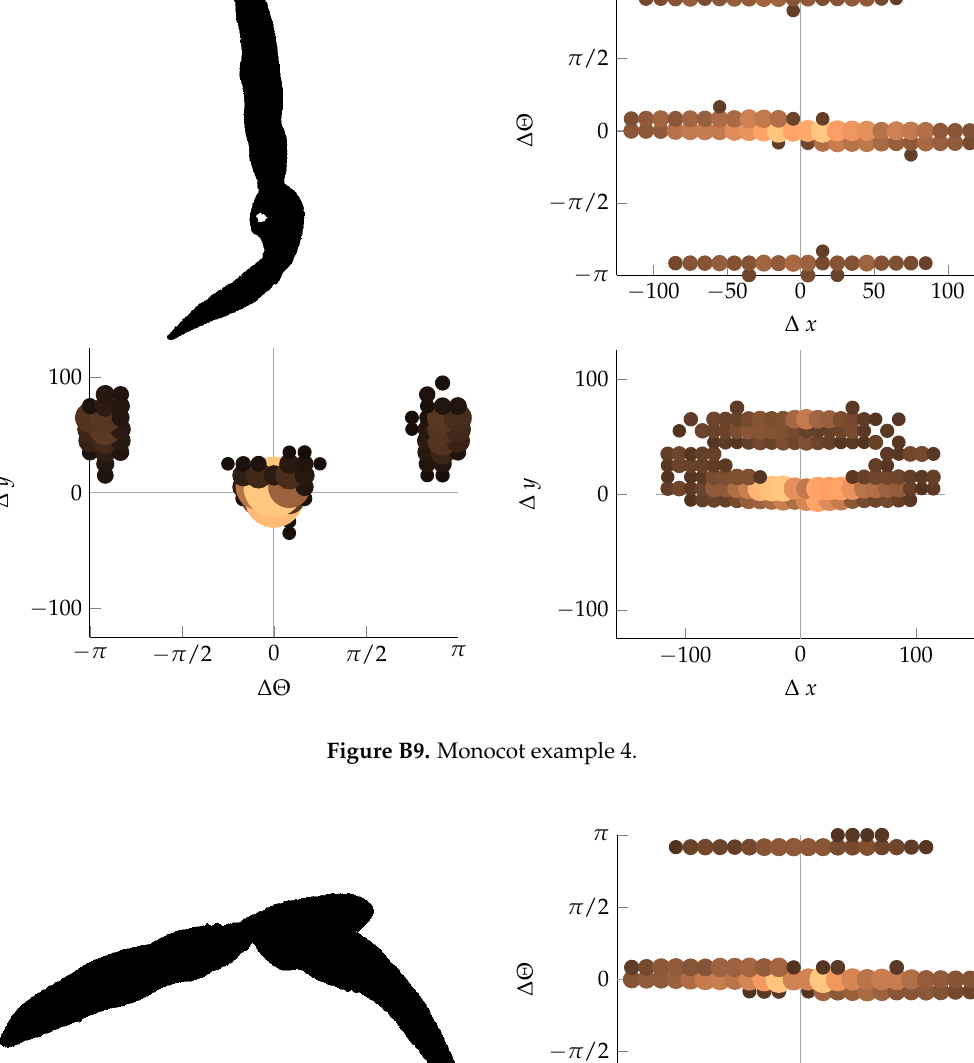
Figure B9. Monocot example 4.